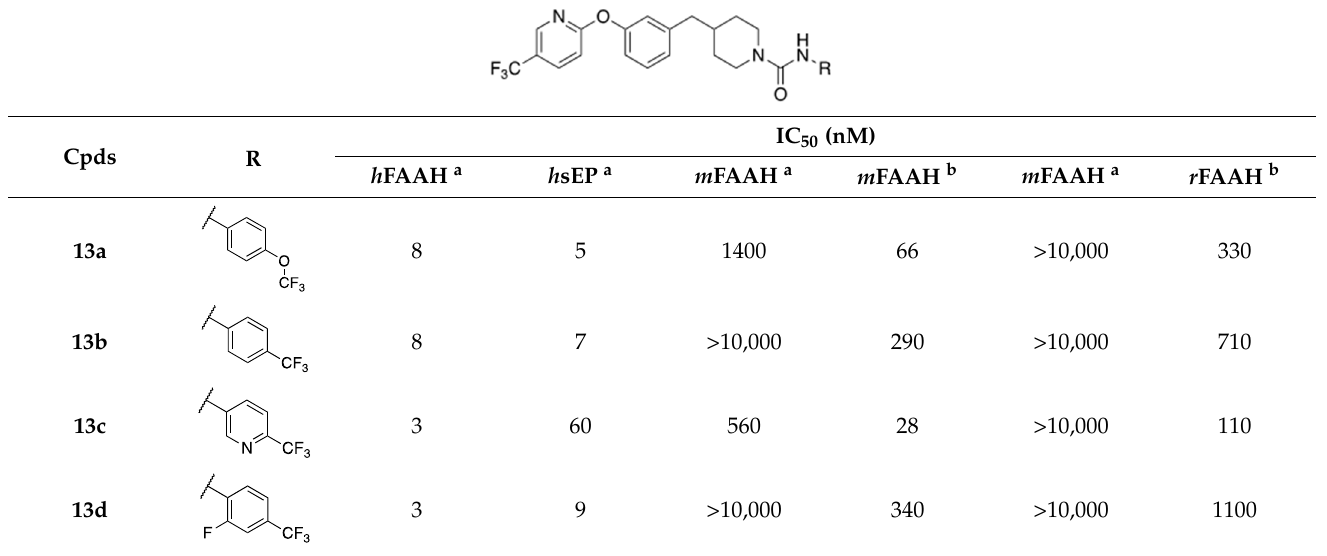
Table 7. FAAH and sEH activities of PF3845 derivatives.